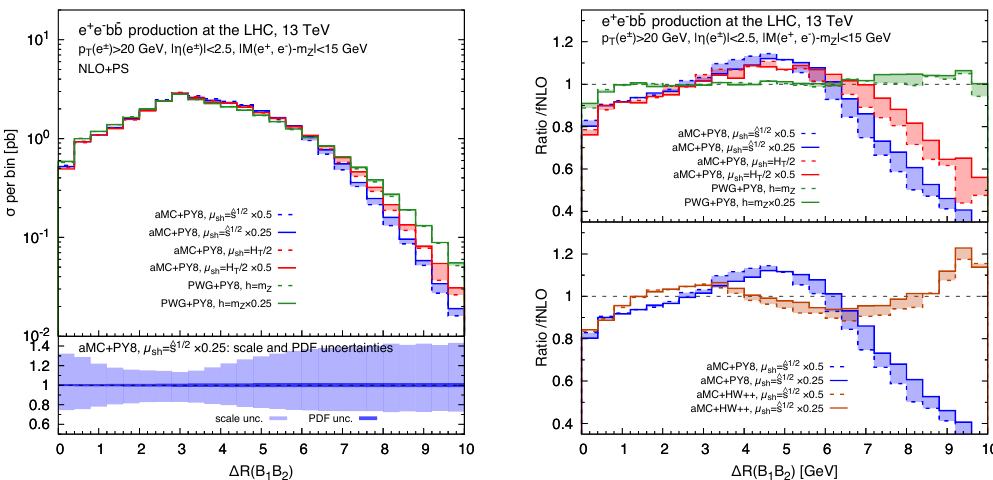
Figure 24 . (cid:1) R distribution of the B hadrons pair in association with at least 0 b jets.